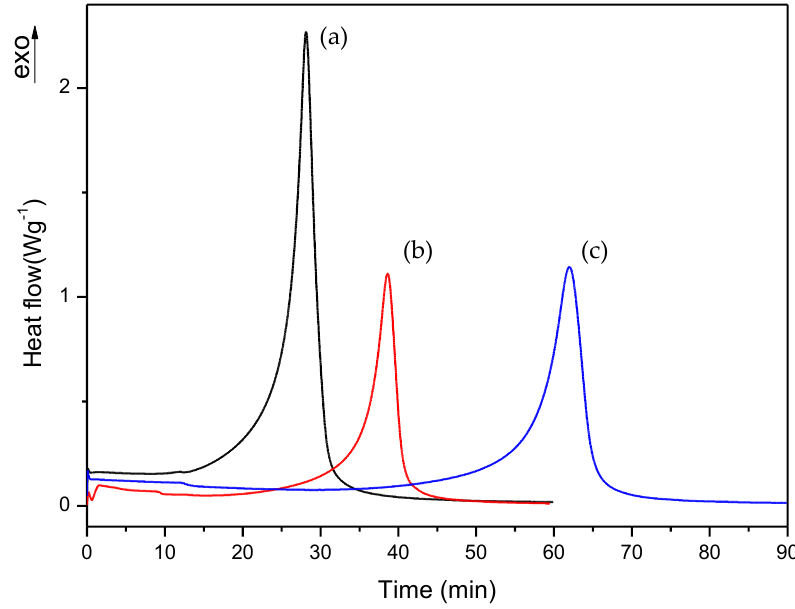
Figure 7. Isothermal DSC curves of (a) A, (b) B and (c) C formulations with 1% DMT.